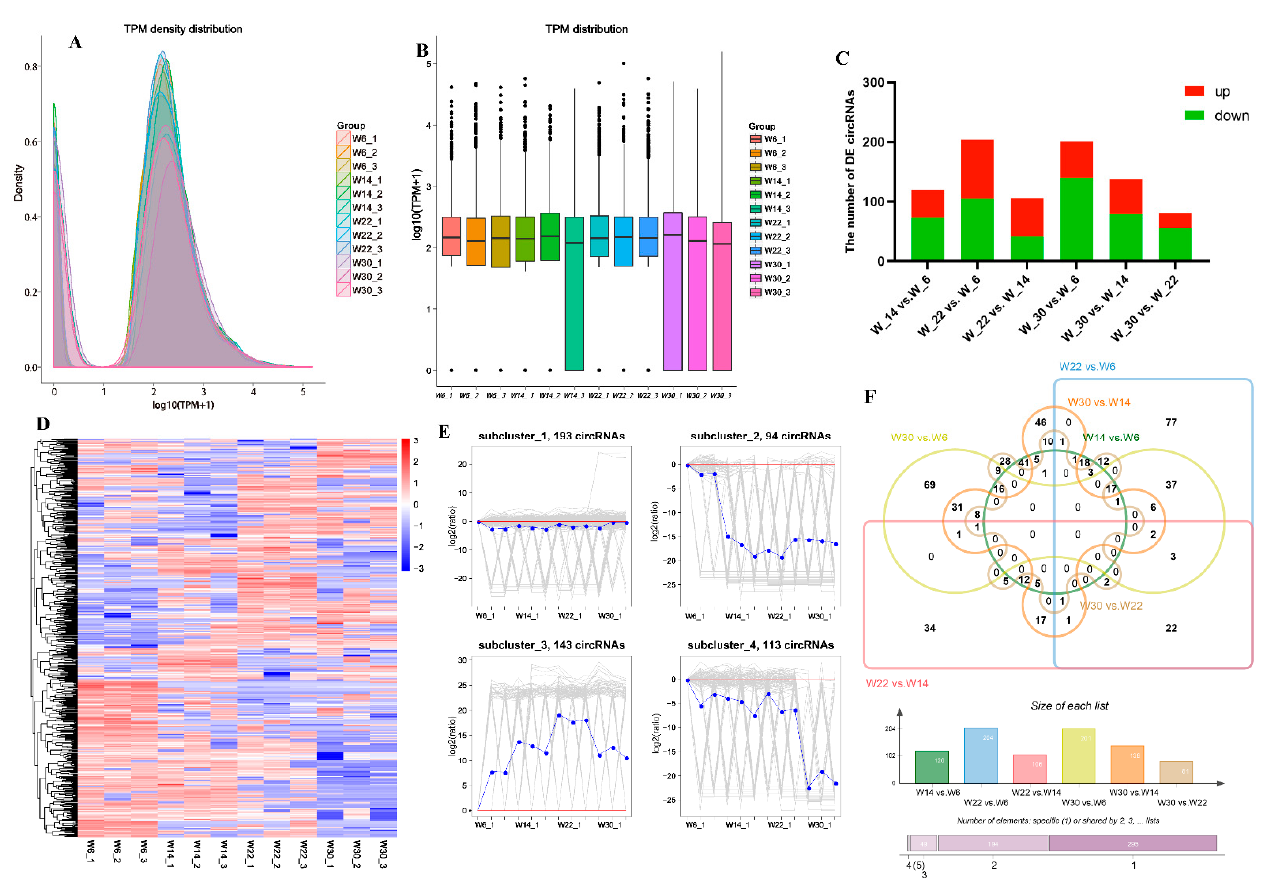
Figure 2. Expression analysis of circRNAs. ( A ) Density distributions of circRNAs TPM values in various libraries. ( B ) Boxplots of TPM values of circRNAs in various libraries. ( C ) DE ‐ circRNAs in six comparison groups. The abscissa represents different comparison groups, and the ordinate represents the number. Green bars represent the number of down ‐ regulated DE ‐ circRNAs, while red bars represent the number of up ‐ regulated DE ‐ circRNAs. ( D ) Hierarchical clustering of DE ‐ circRNAs. ( E ) K ‐ means cluster plot of DE ‐ circRNAs. ( F ) Venn diagram of the DE ‐ circRNAs in different comparison groups.